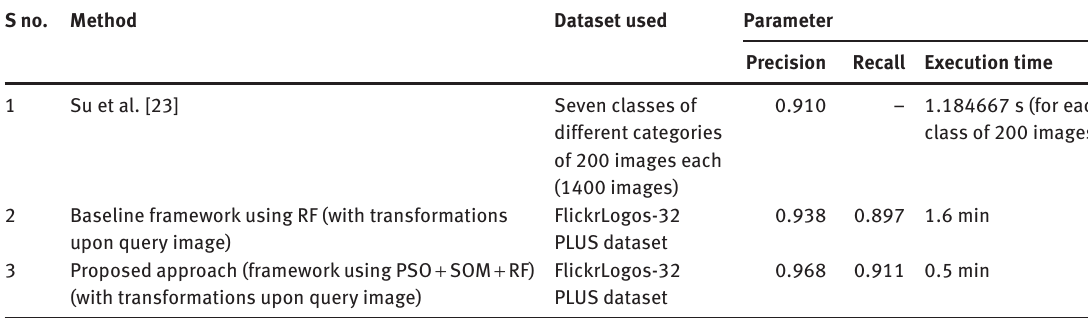
Table 7: Comparison for Su et al. [23] with the Proposed Approach. S no.